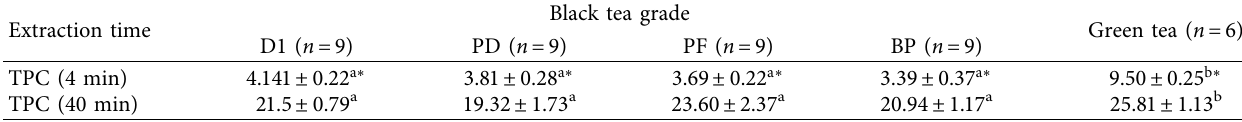
Table 1: Efect of extraction period (minutes) on total phenolic content (TPC) of black tea grades and green tea. Extraction